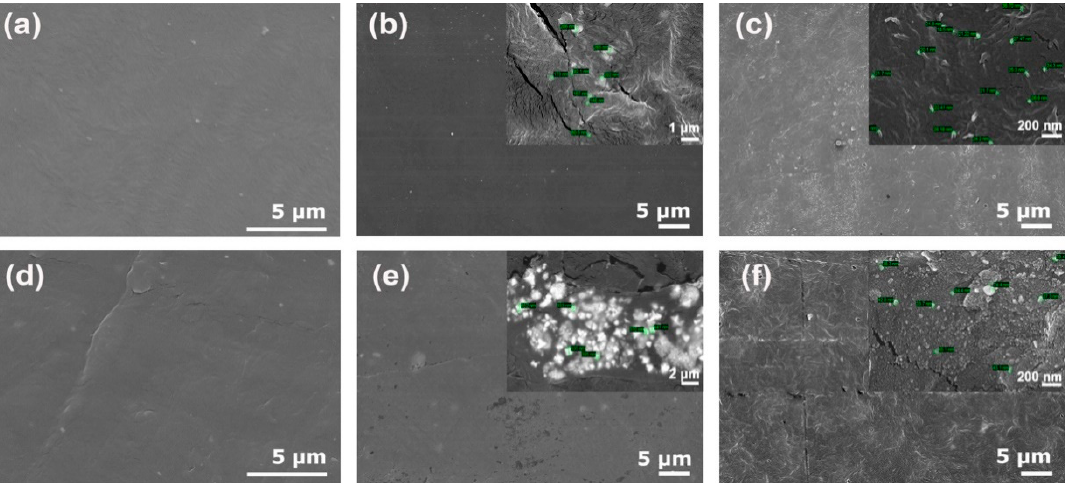
Figure 4. FE-SEM images of ( a ) HDPE, ( b ) HDPE 0.7 wt.% Cu-NCs, ( c ) HDPE 0.5 wt.% Cu-NPs, ( d ) rHDPE, ( e ) rHDPE 0.7 wt.% Cu-NCs, and ( f ) rHDPE 0.5 wt.% Cu-NPs.